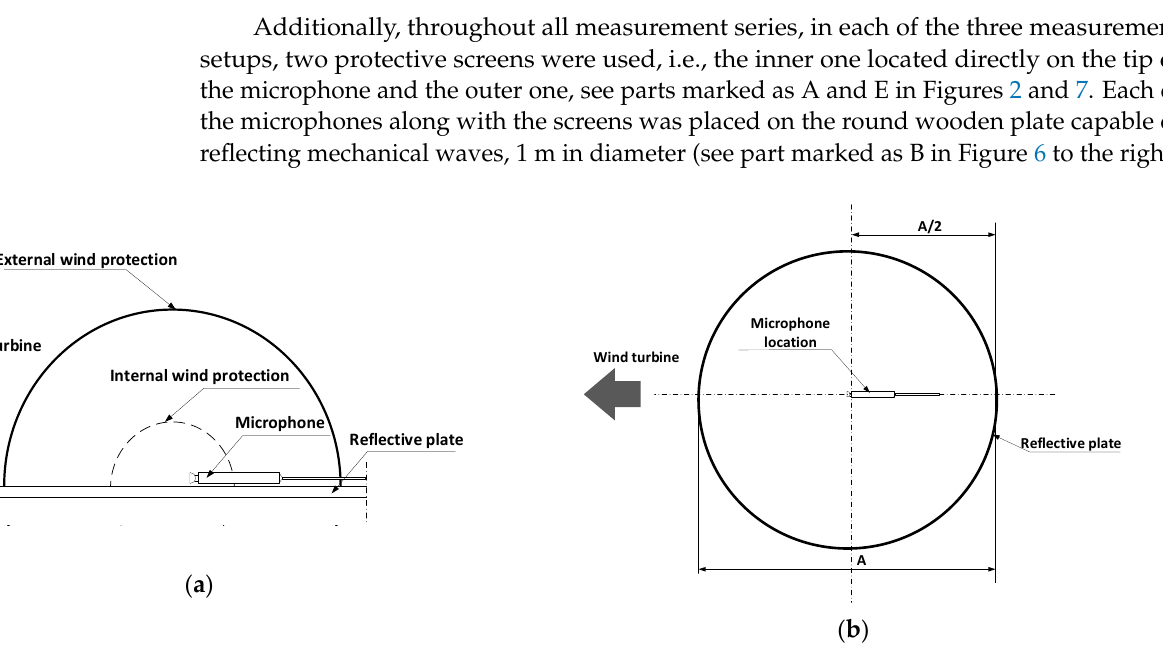
Figure 7. Diagram of the measuring system. ( a ) Microphone reflective board-shields (external and internal); ( b ) Location of the microphone with reflective board, where A = 1 m.